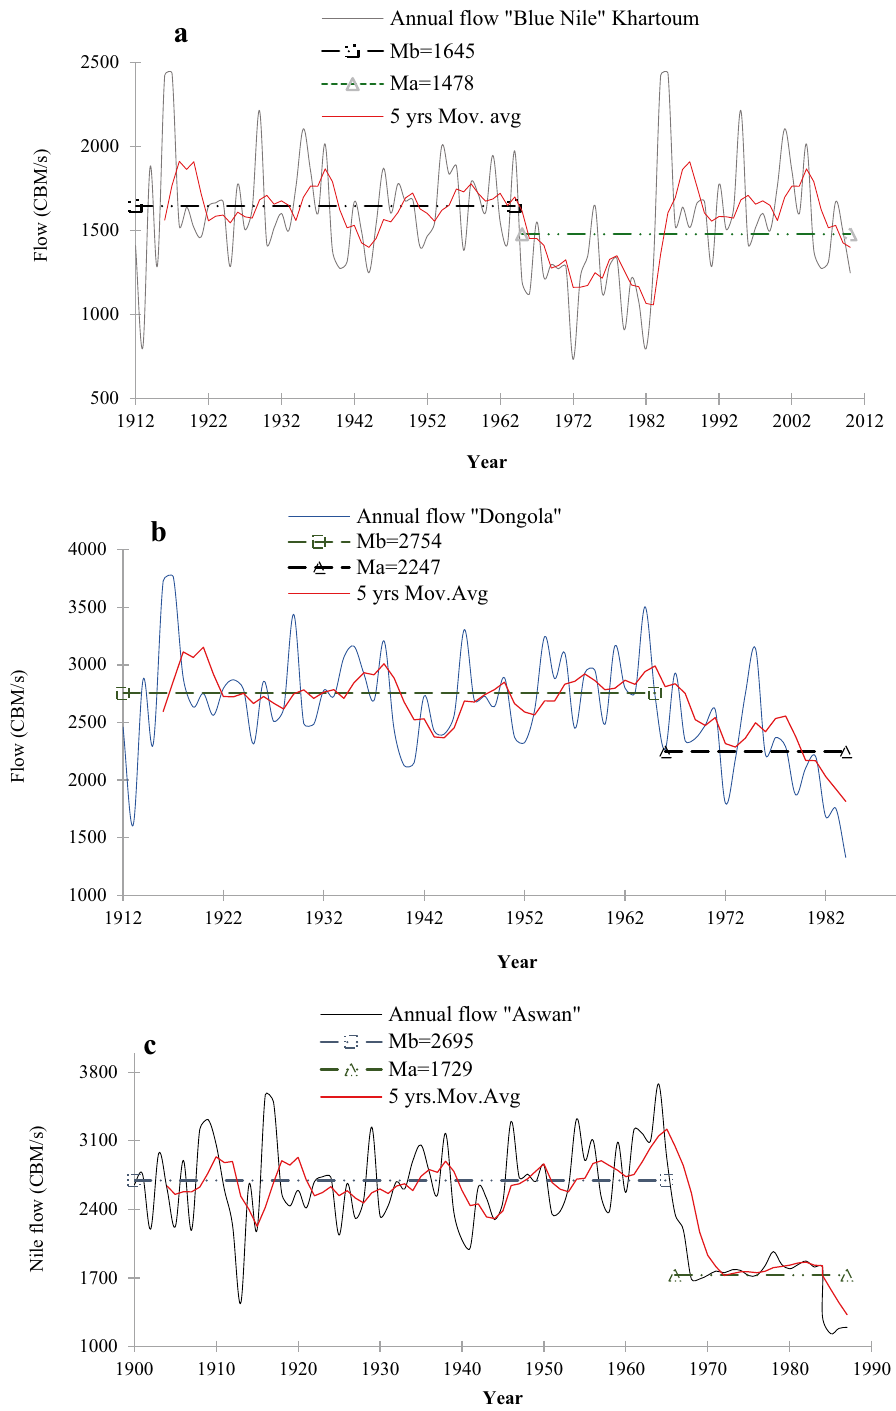
Figure 9. Observed annual flows: ( a ) Blue Nile flow, ( b ) Dongola station flow, and Aswan station flow ( c ). In Fig. 9a, the annual flow of the Blue Nile River decreased from 1645 CBM/s over 1912–1964 to 1478 CBM/s over 1964–2012, with a decreasing trend of about 13.7 CBM/decade after 1964, due to higher AET losses, warmer WIO and IOD, and more intensive El Niño